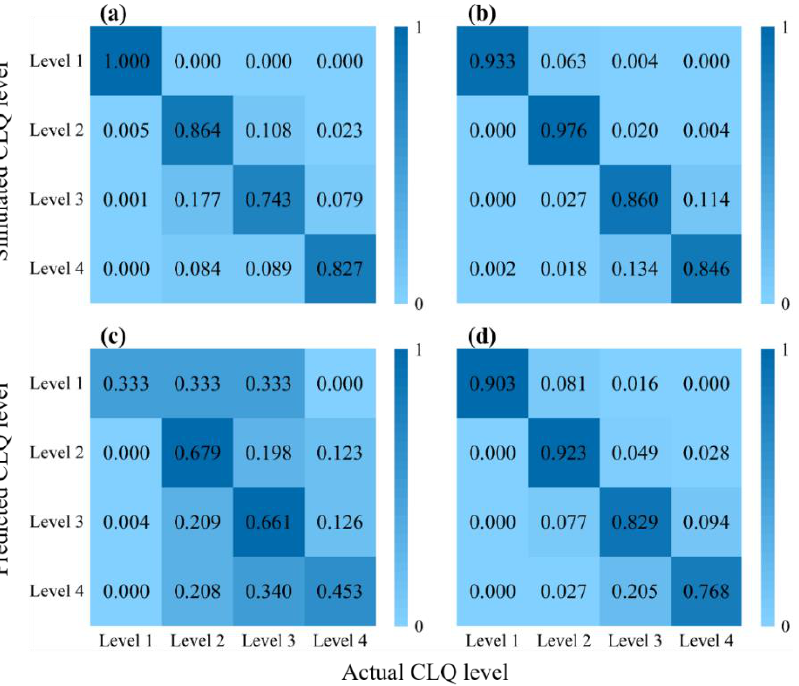
Figure 7. Confusion matrices of results for the ( a ) simulation using the RPA-RF model, ( b ) simulation using the ASP-RF model, ( c ) prediction using the RPA-RF model, and ( d ) prediction using the ASP-RF model.